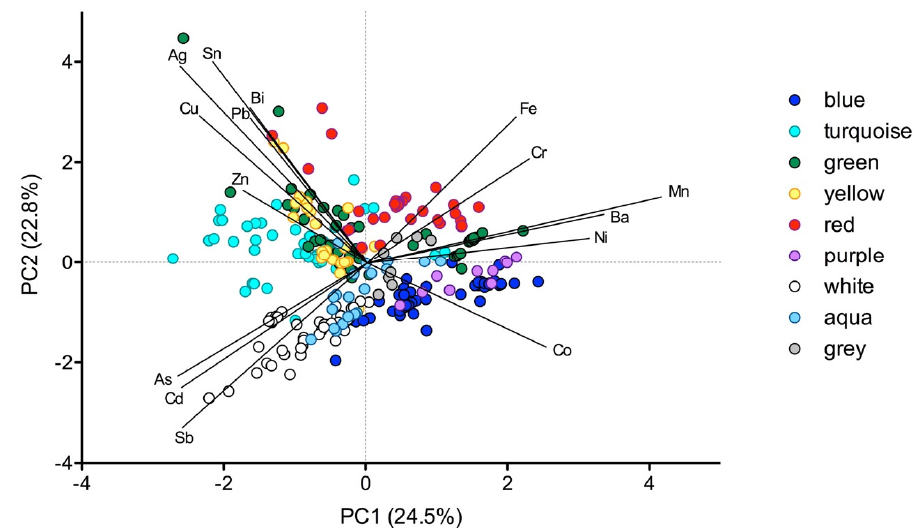
Figure 3. PC1 and PC2 of the main colorants, opacifiers, and their associated trace elements. Please note that the vectors were magnified by one order of magnitude